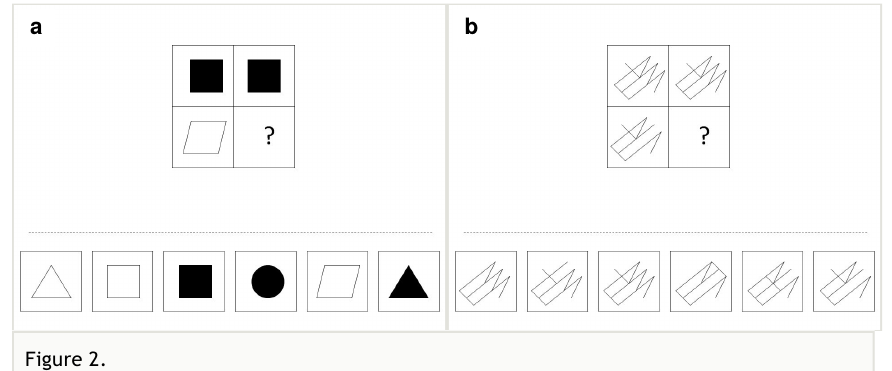
Figure 2. Examples of “Find the same object”